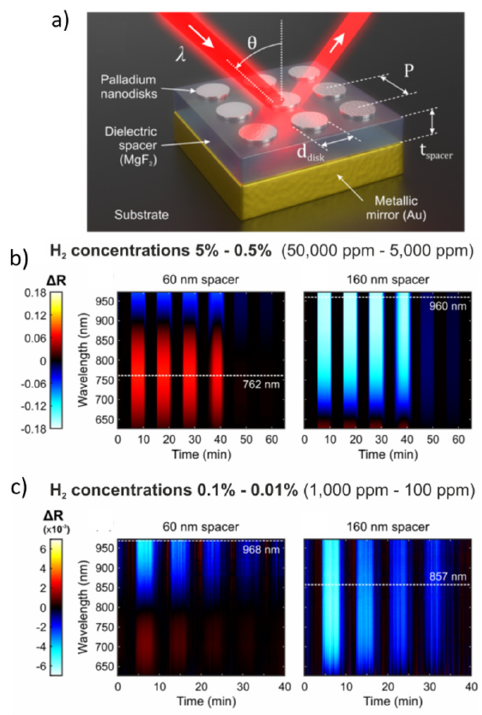
Figure 11. ( a ) Schematic illustration of the plasmonic perfect – absorber − based H 2 sensor. ( b ) Re- flectance of perfect-absorber materials having spacers with a thickness of 60 nm (left graph) and 160 nm (right graph). Each vertical colored line (blue and red in the left graph, and light blue in the right graph) corresponds to a period when the materials are exposed to a fixed H 2 concentration. Dashed white lines show the maximum reflectance difference. ( c ) As in panel (b) but for reflectance meas- urements upon cycling H 2 concentrations ranging from 0.1 to 0.01%. Reproduced from [92], with permission from ACS Publications, 2020.